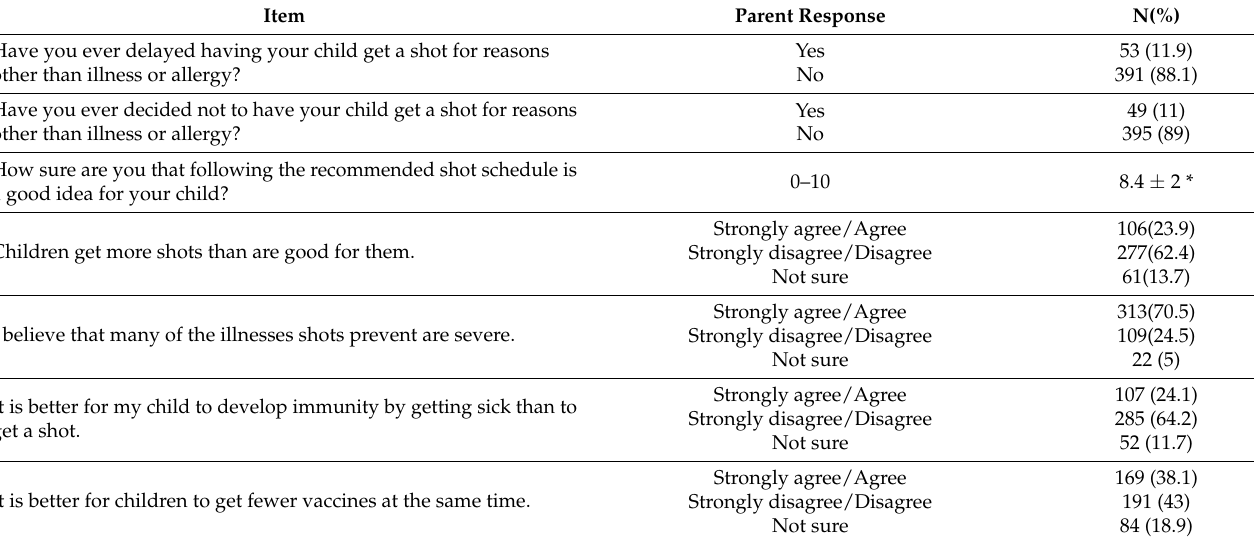
Table 3. Descriptive characteristics of